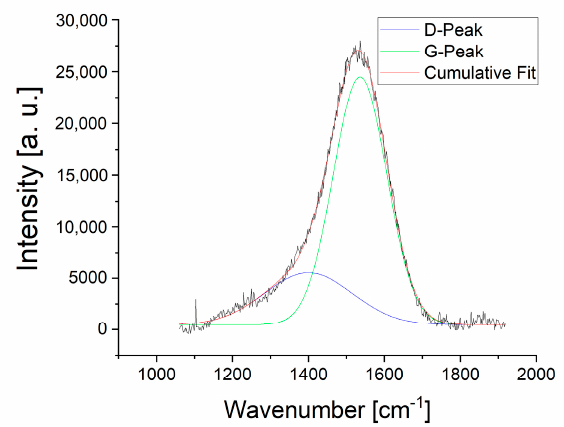
Figure 5. Raman spectrum of the deposited coating with an excitation wavelength of 514 nm.